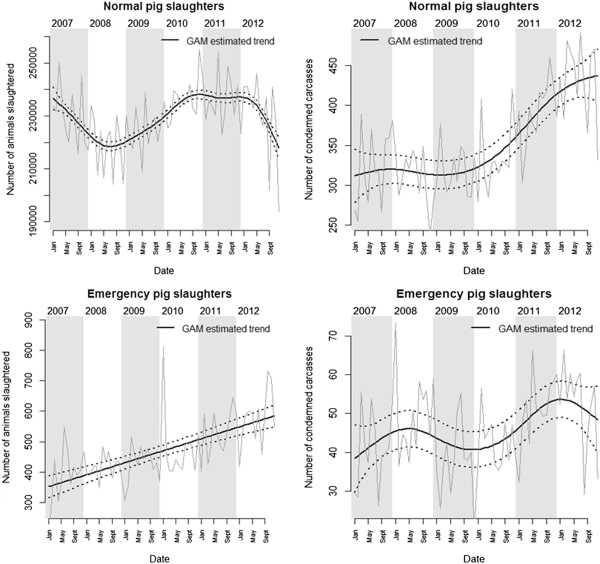
GAM estimated trends for the number of pig carcasses. Monthly numbers of pigs slaughtered (left) and condemned carcasses (right) between 2007 and 2012 during normal slaughter (top) and emergency slaughter (bottom) are presented.